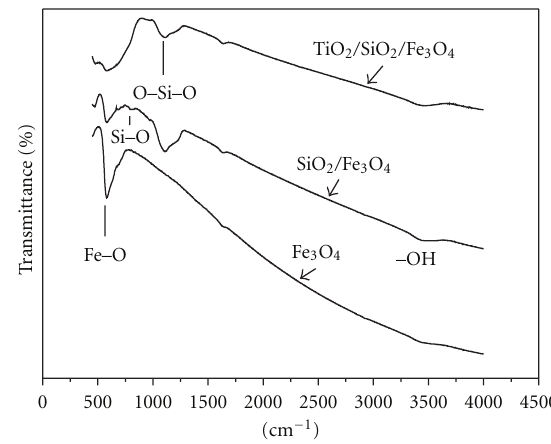
Figure 2: FTIR spectra of Fe 3 O 4 , SiO 2 /Fe 3 O 4 , and TiO 2 /SiO 2 / Fe 3 O 4